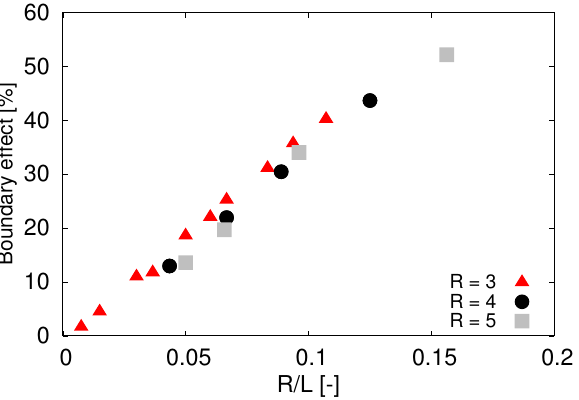
Figure 4. Boundary effect—relative deviation of computed terminal velocity from the theoretically predicted value. Sphere radius R given in µ